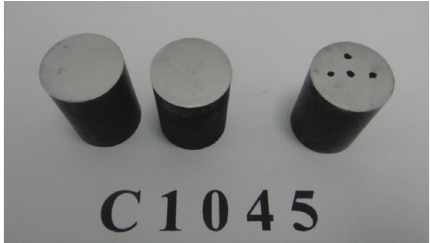
Figure 2: Three test pieces with the heat treatment temperature 760 ∘ C (the marked points at the right piece for the hardness testing).